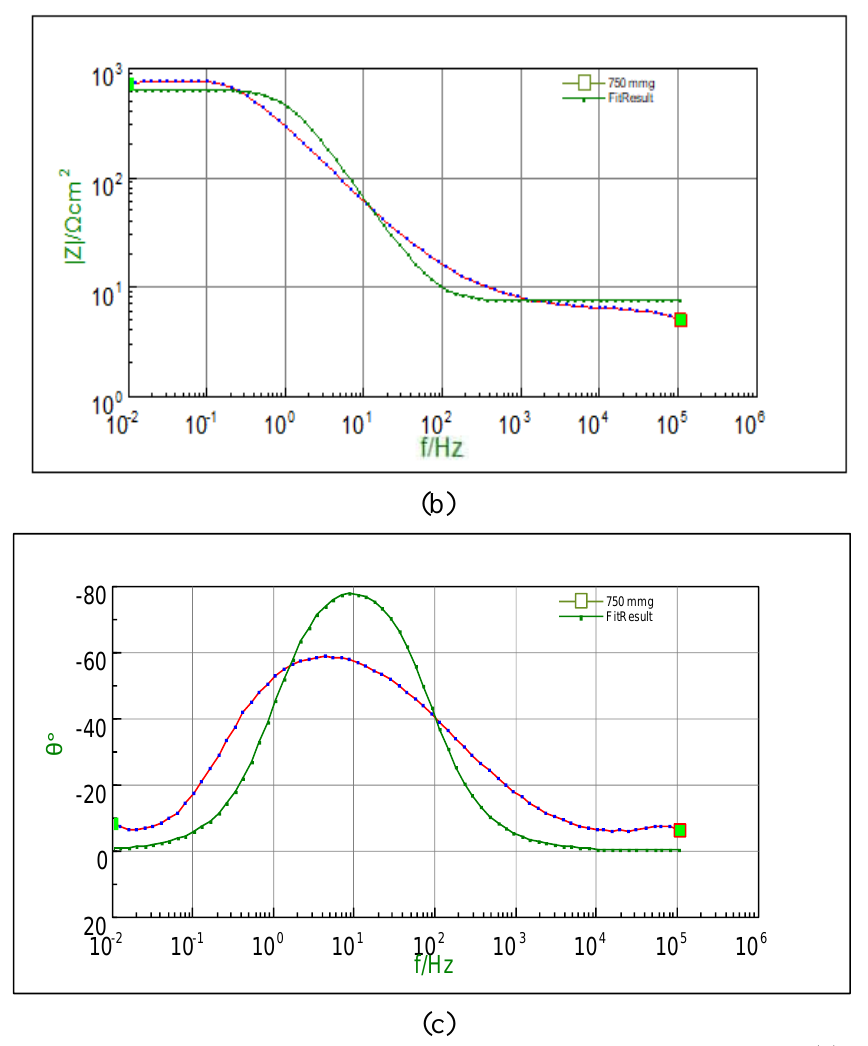
Fig. 12. The EIS test for 750 mg/l concentration of inhibitor at 35◦C with the fitting result. (a) Nyquist plot, (b, c) Bod (log versus |z|), and phase angle (log f versus ∝ 𝟎 )